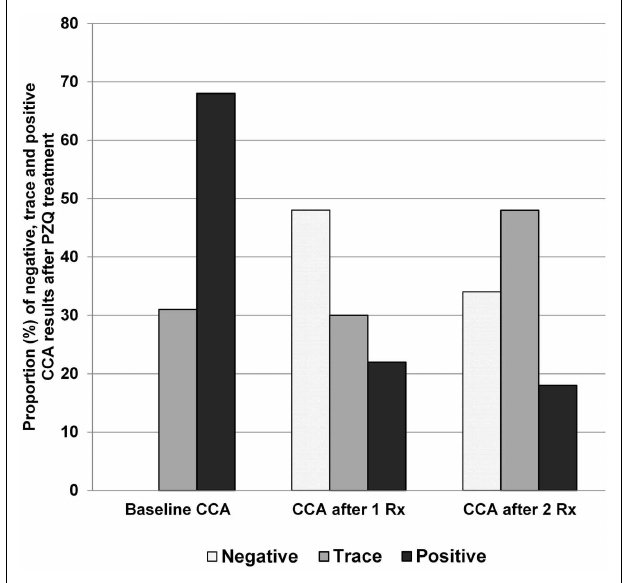
FIGURE 4 | POC-CCA results following two rounds of praziquantel treatment, Kenya